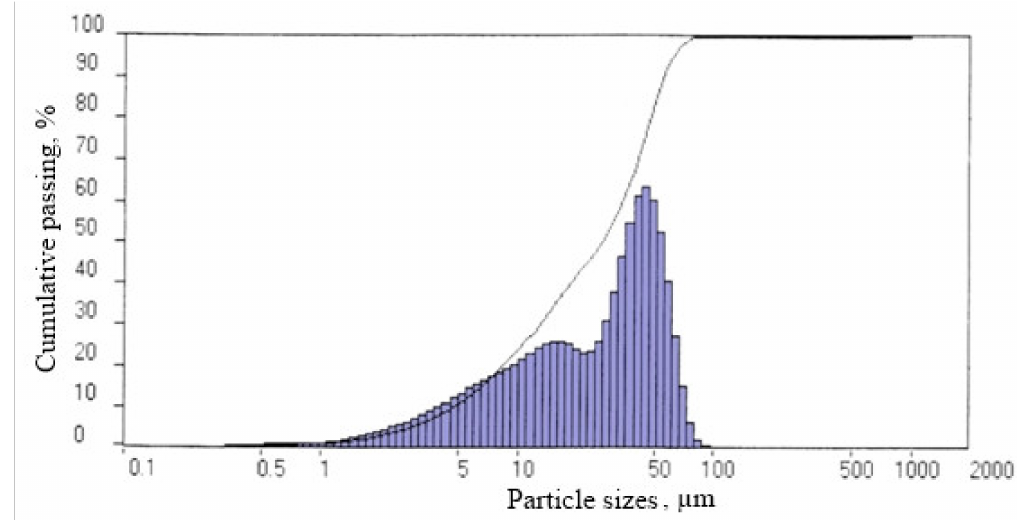
Figure 2. Granulometric composition of the filler obtained by synthesis in the presence of CaCl 2 in the form of a 15%